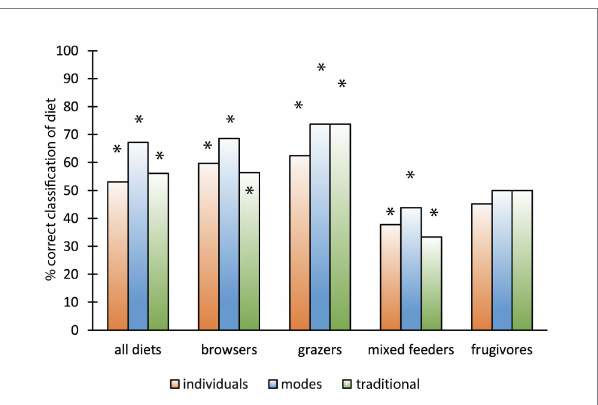
FIGURE 6 Percent of species whose a priori and a posteriori dietary assignments were correctly matched using the jackknifed DFA results. Asterisks (*) are the percent of correct matches in the analyses excluding